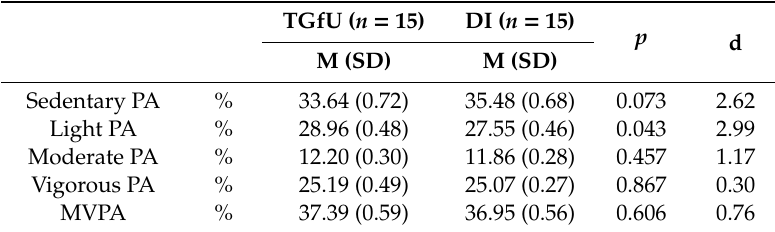
Table 3. Di ff erences in physical activity levels according to the pedagogical approach (Teaching Games for Understanding [TGfU] vs. Direct Instruction [DI]).